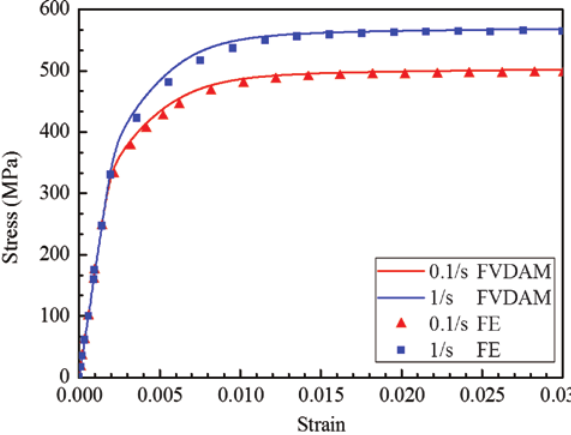
Figure 3: Transverse stress-strain response of MMCs at strain rates of 0.1/s and 1/s. Comparison with FEM results.